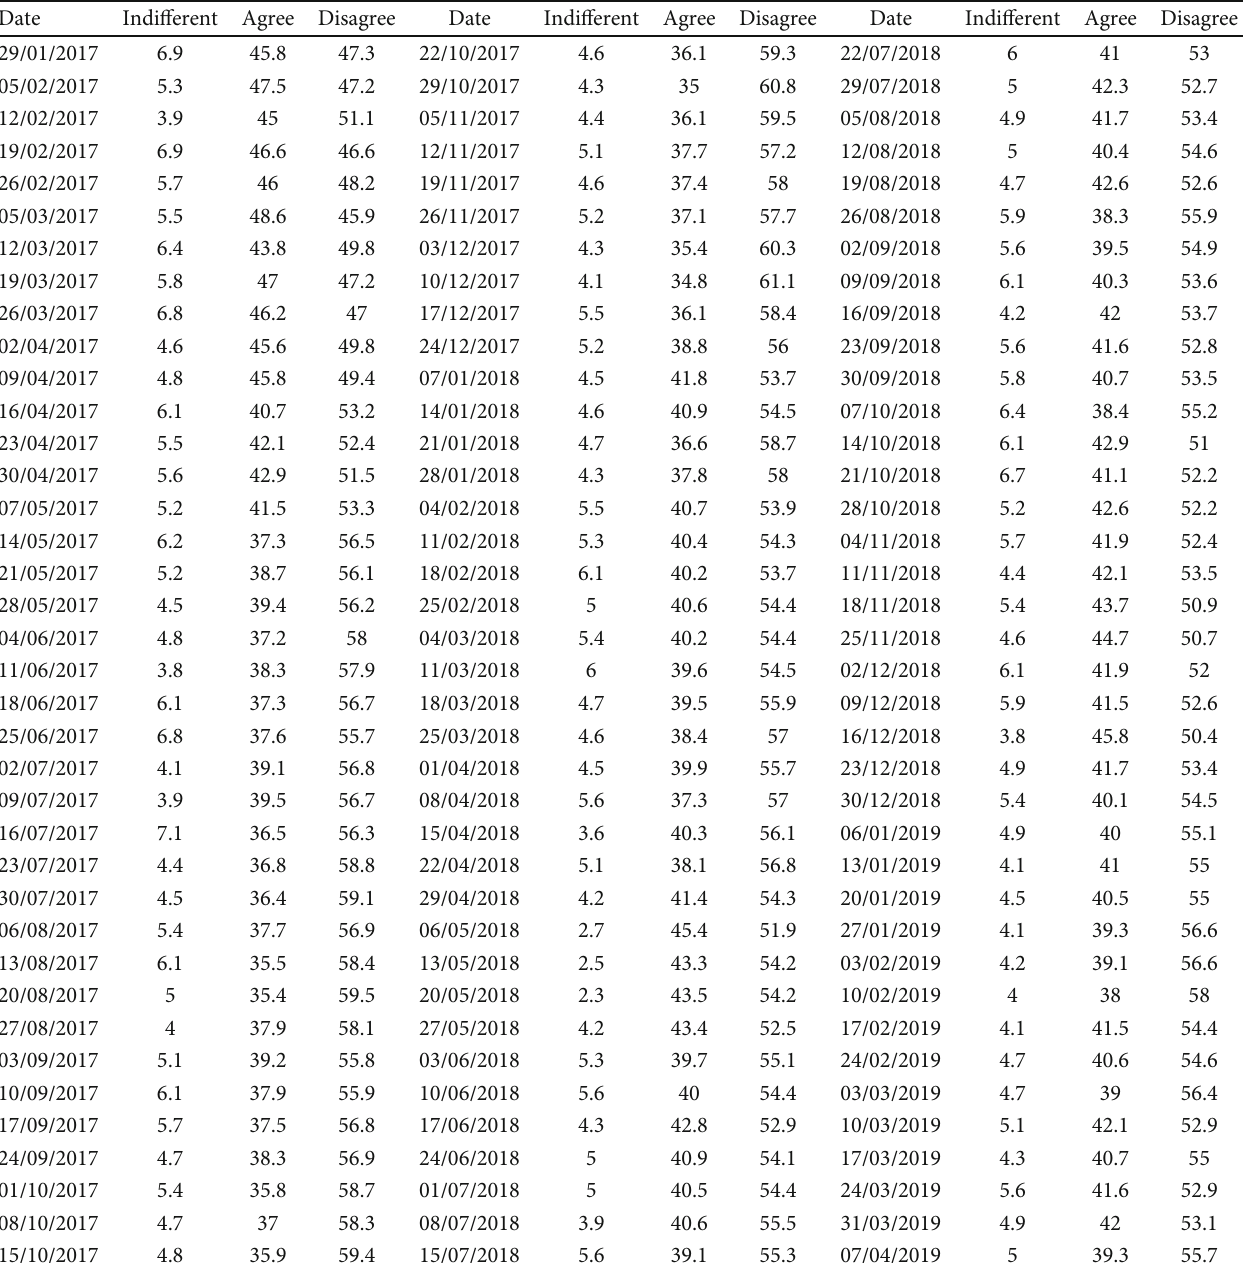
Table 4: Data of the second poll from